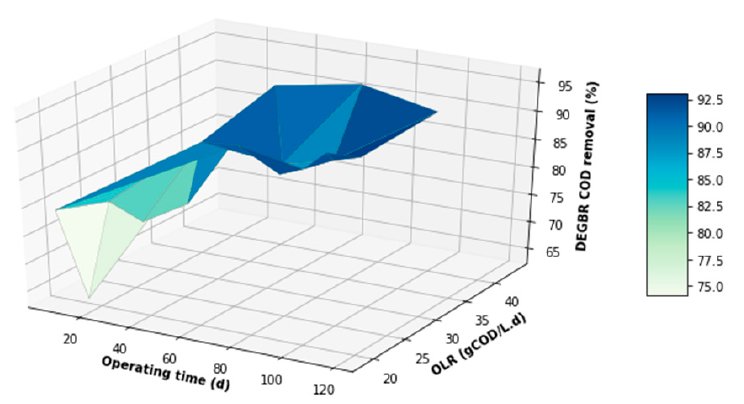
Figure 16. DEGBR COD removal with respect to the operating time and the OLR.